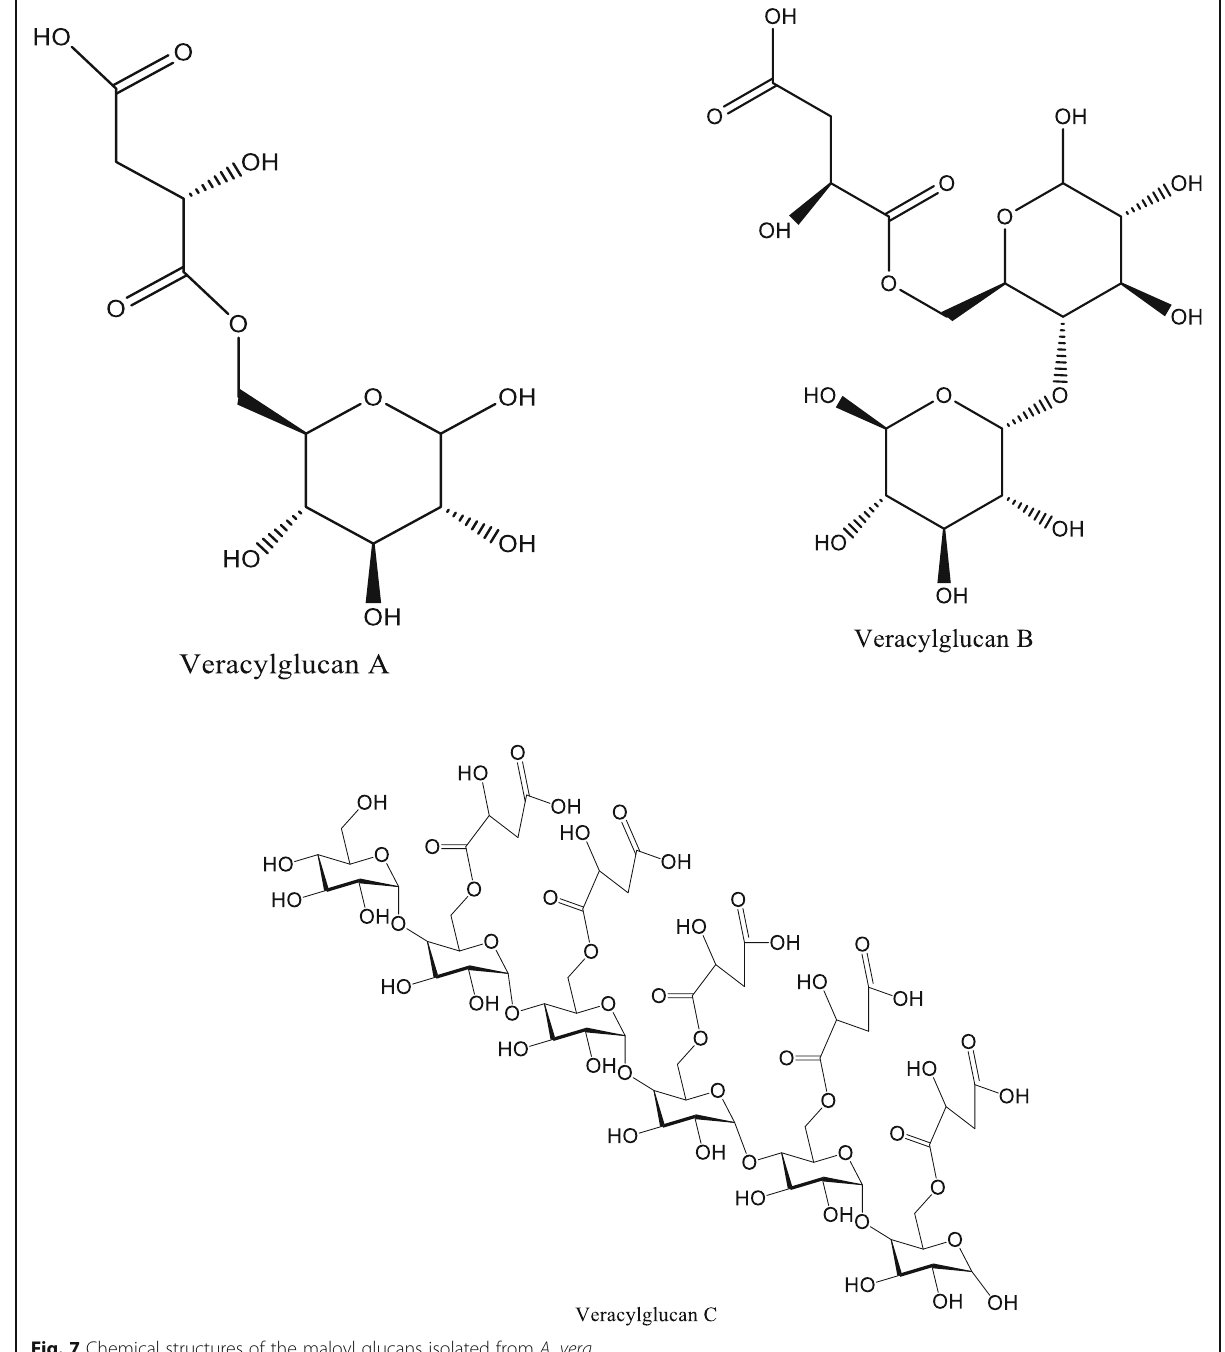
Fig. 7 Chemical structures of the maloyl glucans isolated from A.